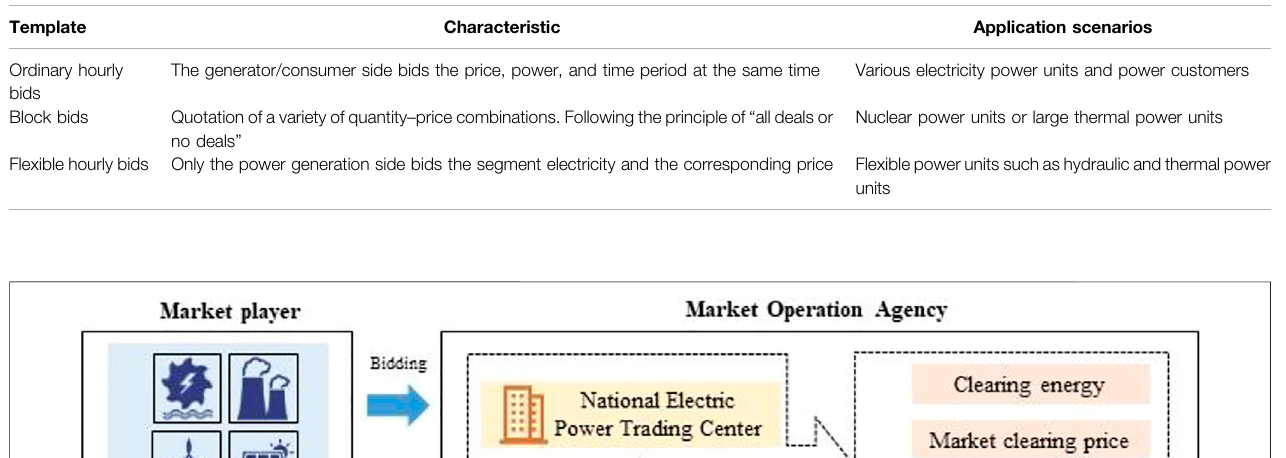
TABLE 2 | Types of electrical bid template.